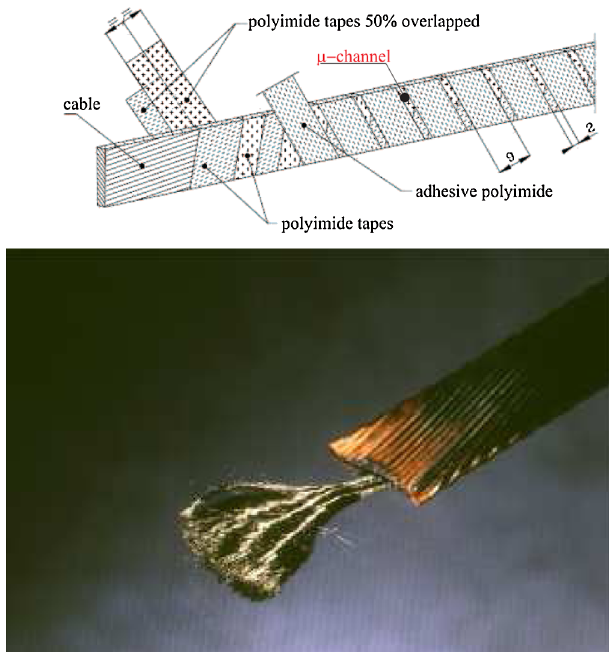
FIG. 9. (Color) Close-up of a single cable where the current carrying strands, and the filaments composed of NbTi, are